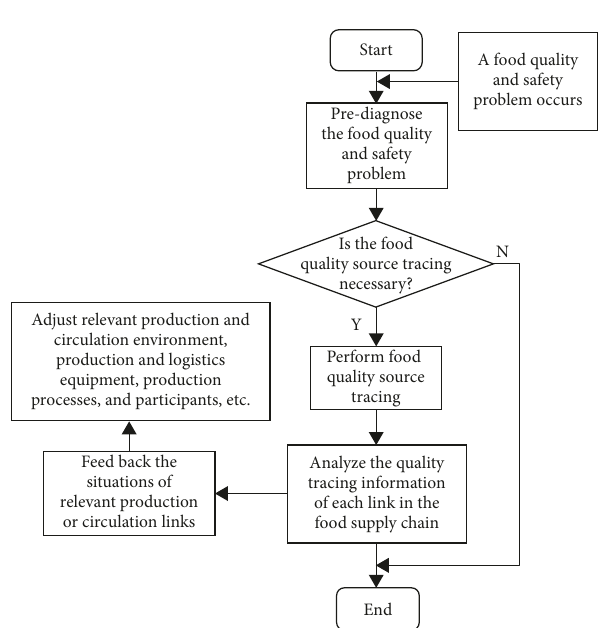
Figure 5: Technical route of food quality source tracing.